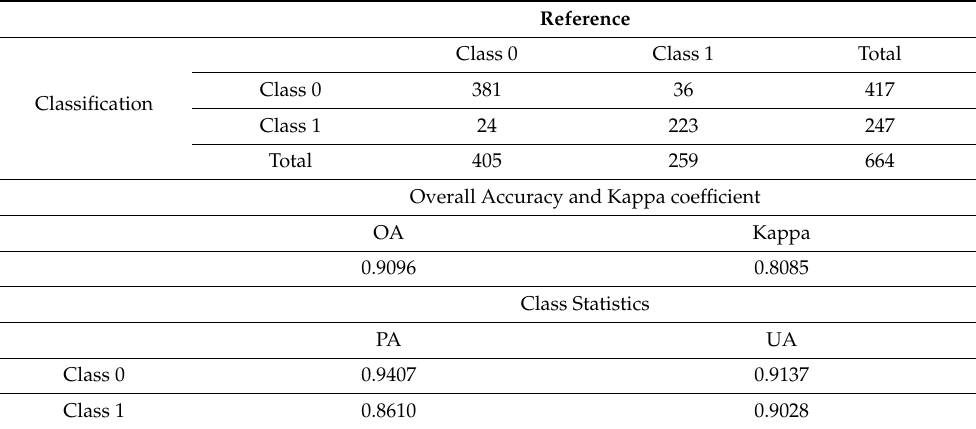
Table A9. PS + GLCM MAX + Topo + CHM classification (“scheme